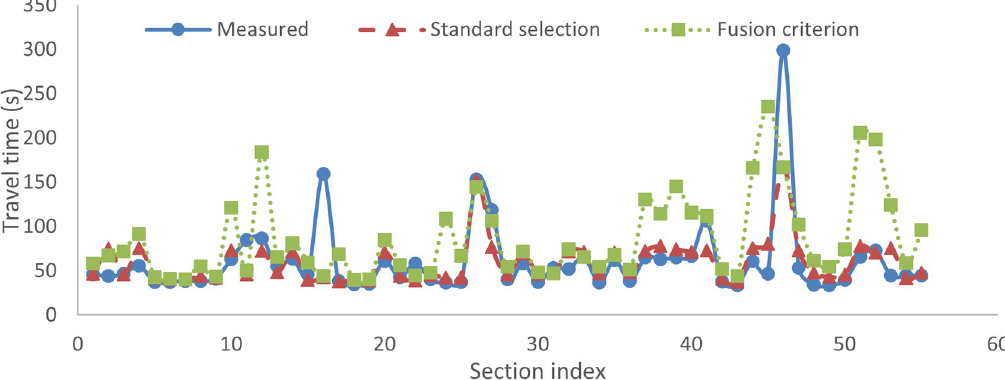
Fig 8. Measured and predicted travel times for a sample trip (standard selection vs. fusion